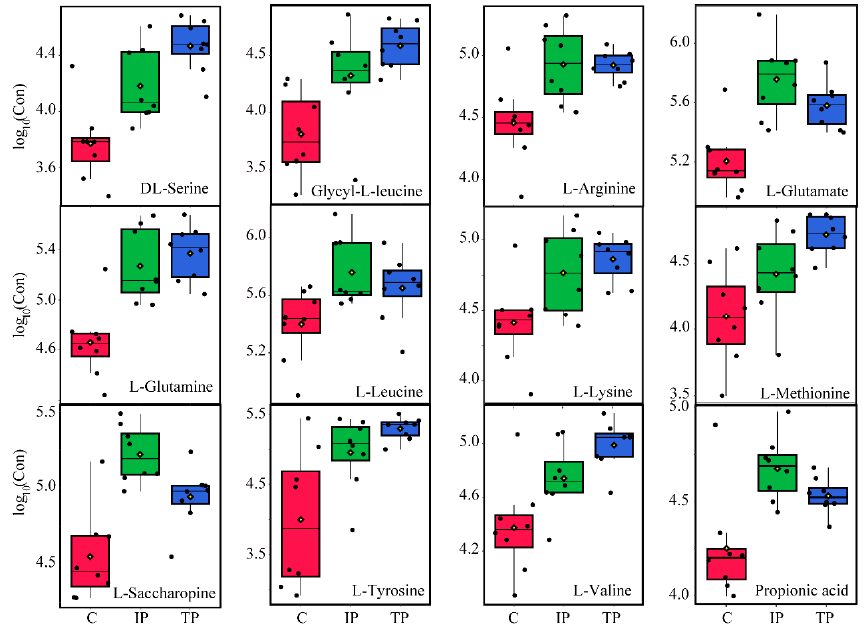
Figure 6. Changes in concentration distribution of important amino acid metabolites in P. oxalicum with tricalcium phosphate (TP-Blue), iron phosphate (IP-Green), and dipotassium phosphate (C-Red) treatments. The black dots represent the concentration of amino acids from eight samples. In terms of TP vs. Sol-P and IP vs. Sol-P, 45 and 55 metabolites with significant intensity increases and decreases were screened, respectively. Up-regulations of P. oxalicum protein,